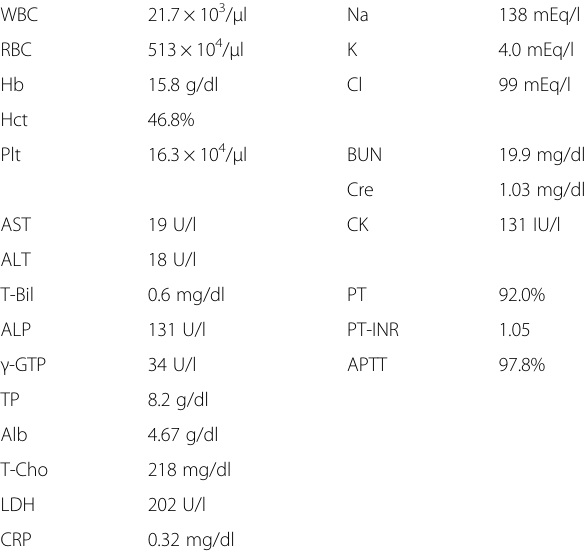
Table 1 Laboratory data on admission